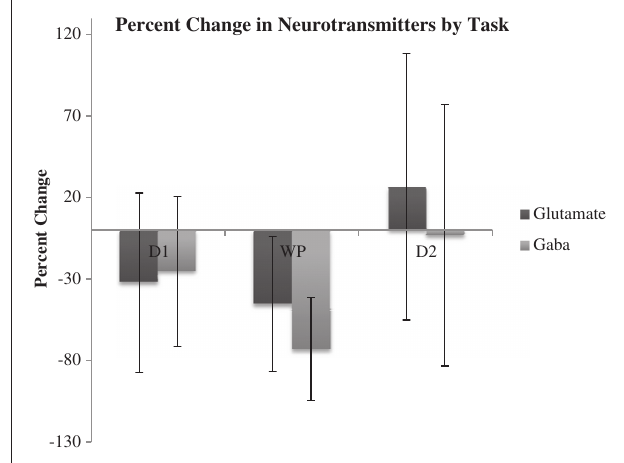
FIGURE 5 | Average percent change of Glu and GABA from baseline during declarative tasks (D1, D2) and WTP with 95% confidence